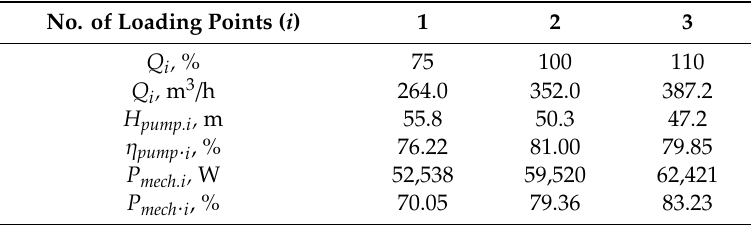
Table 2. Pump loading cycle parameters.